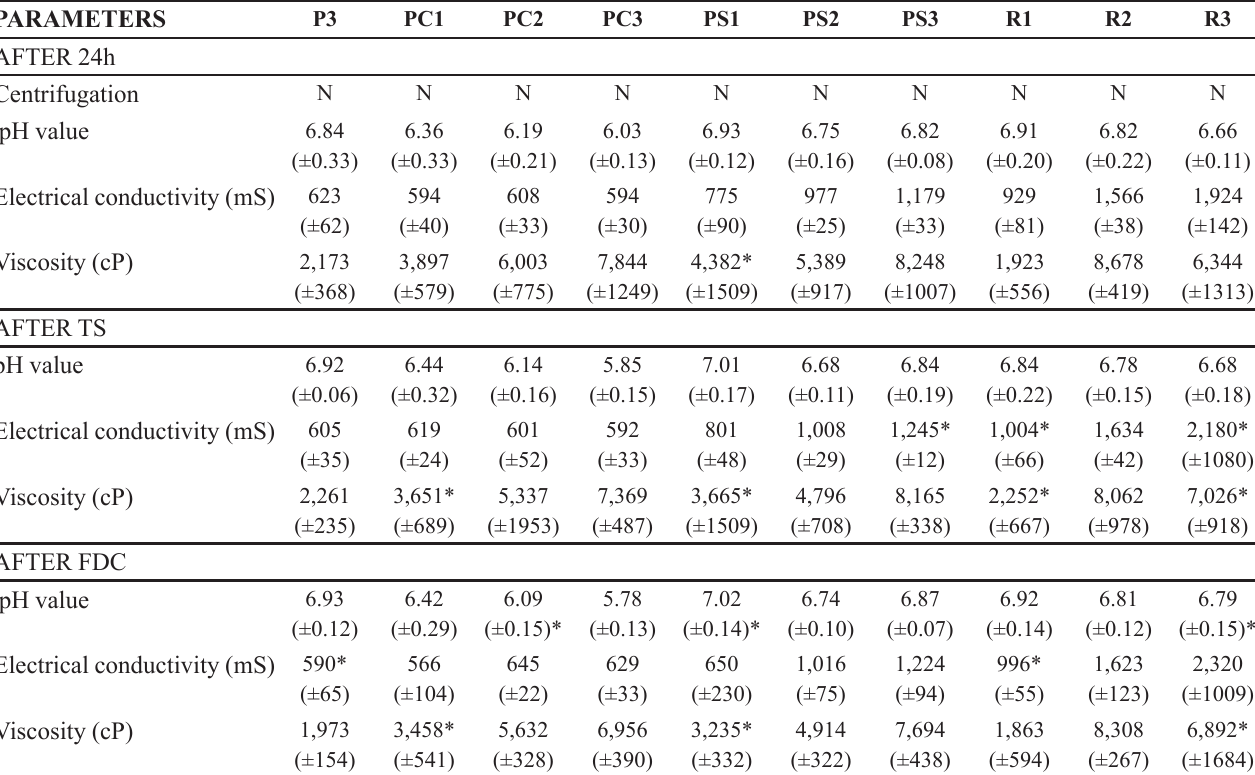
TABLE II - Results of preliminary stability tests of emulsions containing açai glycolic extract